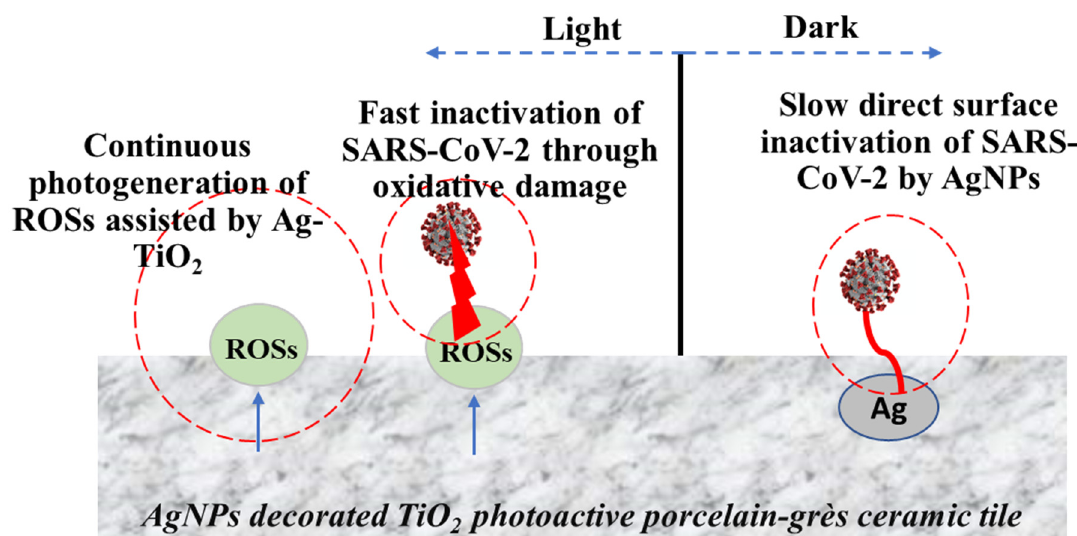
Figure 4. Mechanistic pathways of SARS-CoV-2 inactivation on the surface of Ag-decorated TiO 2 porcelain-grès tiles with light irradiations (UVA or LED) or in the dark.